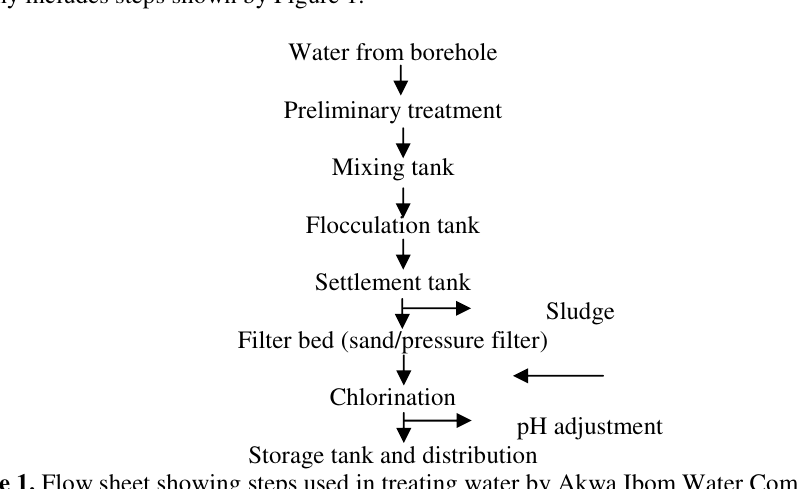
Figure 1. Flow sheet showing steps used in treating water by Akwa Ibom Water